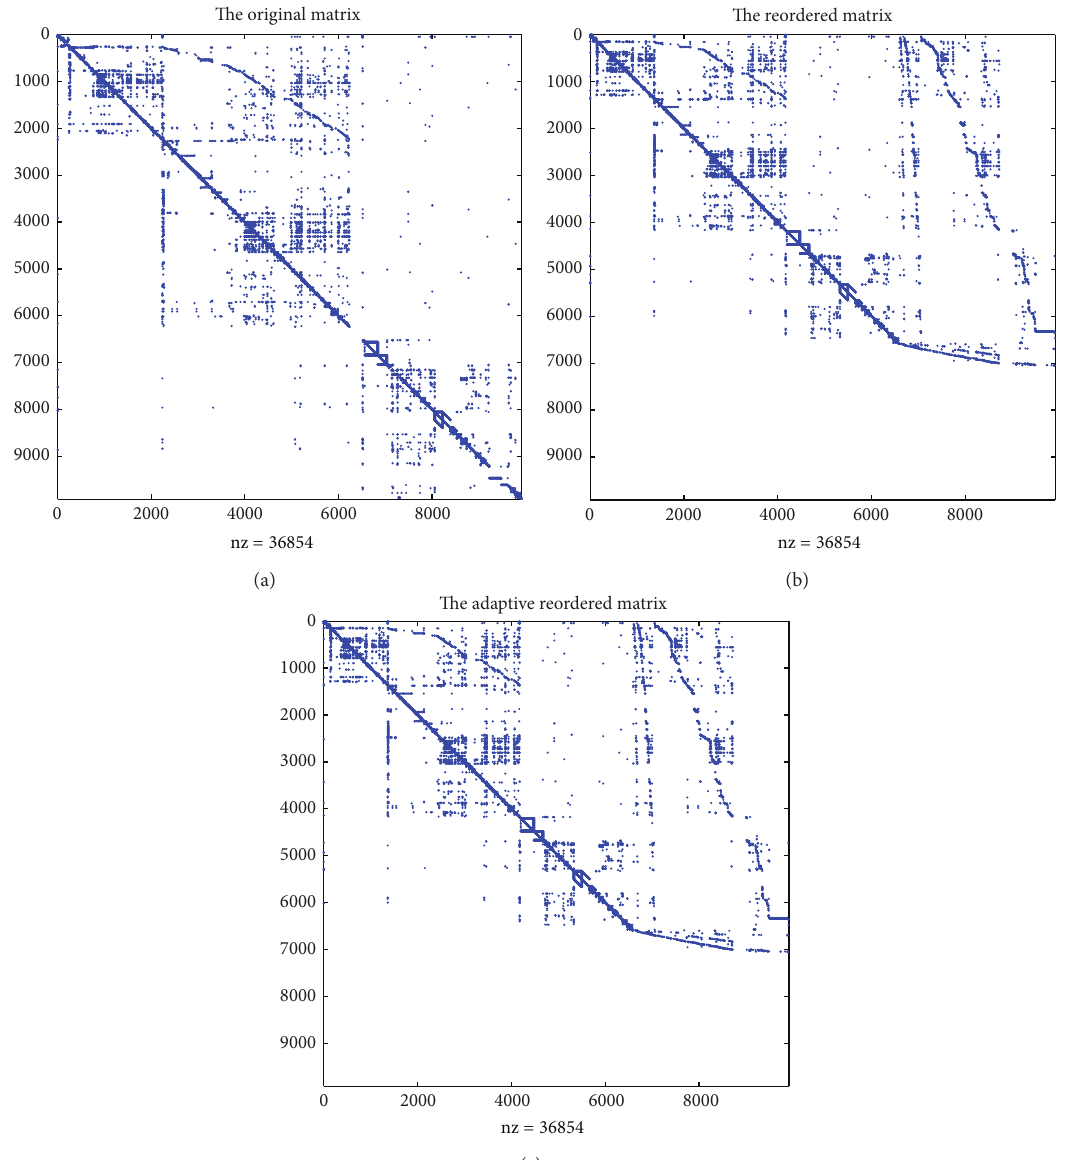
and 𝑡2 . With respect to wb-cs-stanford.mat , there are four blocks if aRD is used and their sizes are 6592, 88, 356, and